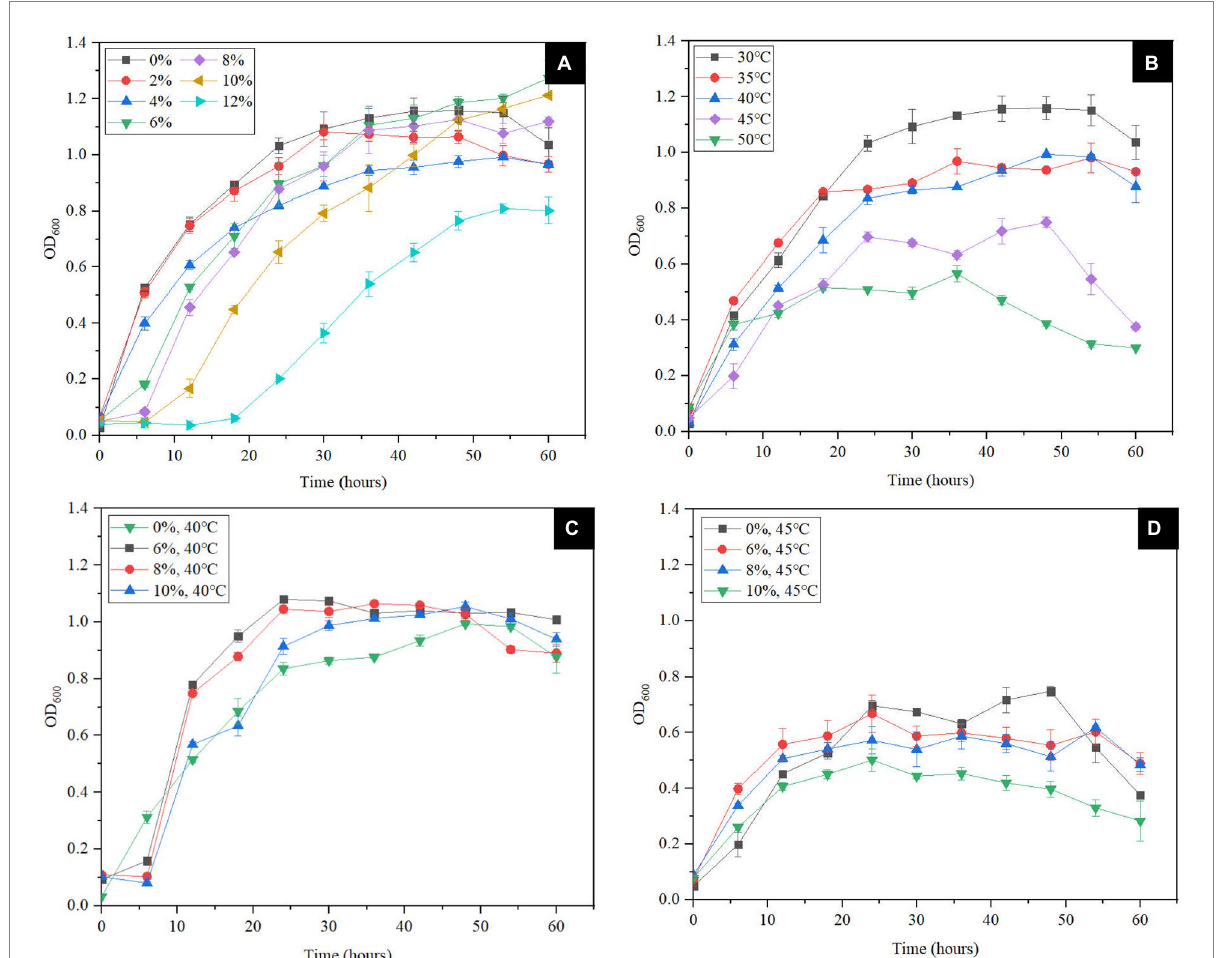
FIGURE 2 Effects of different NaCl concentrations (0, 2, 4, 6, 8, 10 and 12% w/v) (A) and different temperatures (30 ° C, 35 ° C, 40 ° C, 45 ° C, and 50 ° C) on bacterial growth (B) , effects of different NaCl concentrations (0, 6, 8 and 10% w/v) on bacterial growth at 40 ° C (C) and 45 ° C (D)